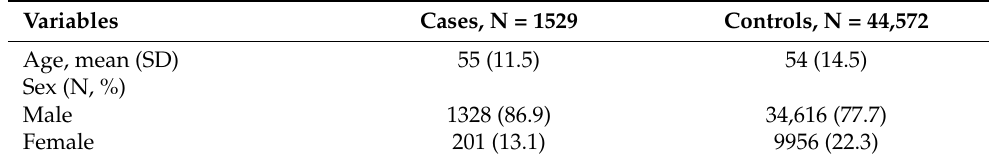
Table 1. Selected characteristics of the study